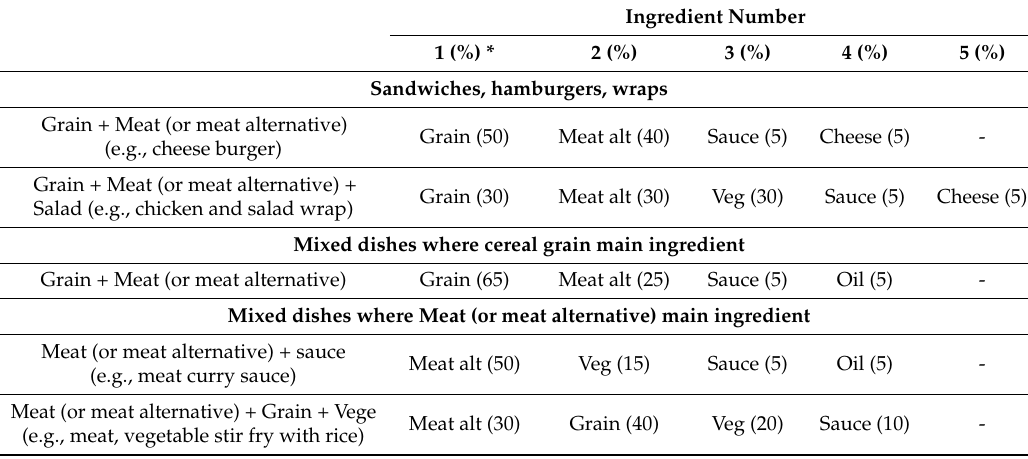
Table 1. Examples of ingredient composition percentages of mixed